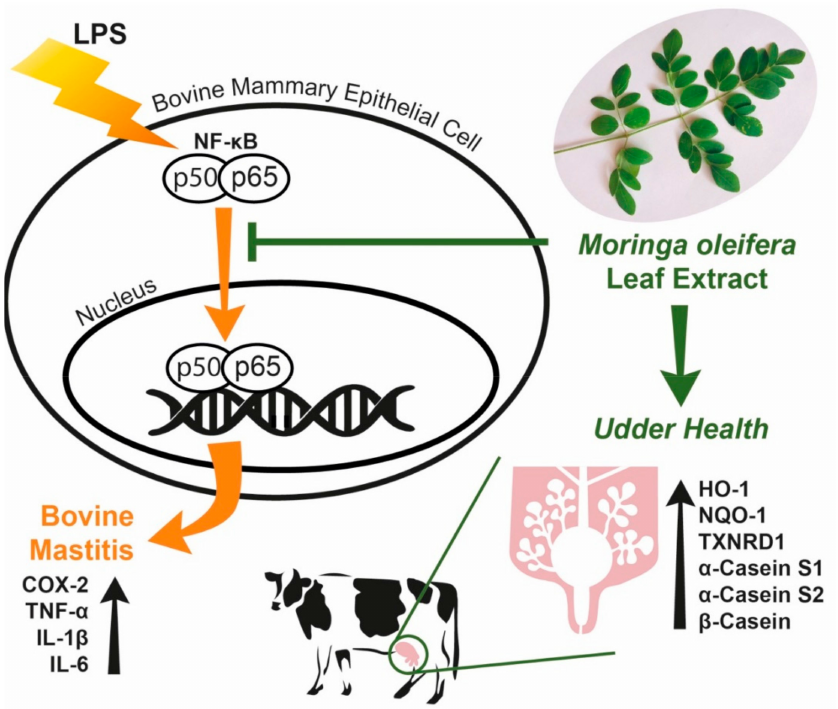
Figure 8. Protective role of moringa extract in LPS-challenged bovine mammary epithelial cells. Moringa extract decreases cellular inflammatory responses induced by LPS in bovine mammary epithelial cells through down-regulation of NF- κ B, COX-2, TNF- α , IL-1 β and IL-6. Moringa extract increases gene expression of casein and antioxidant